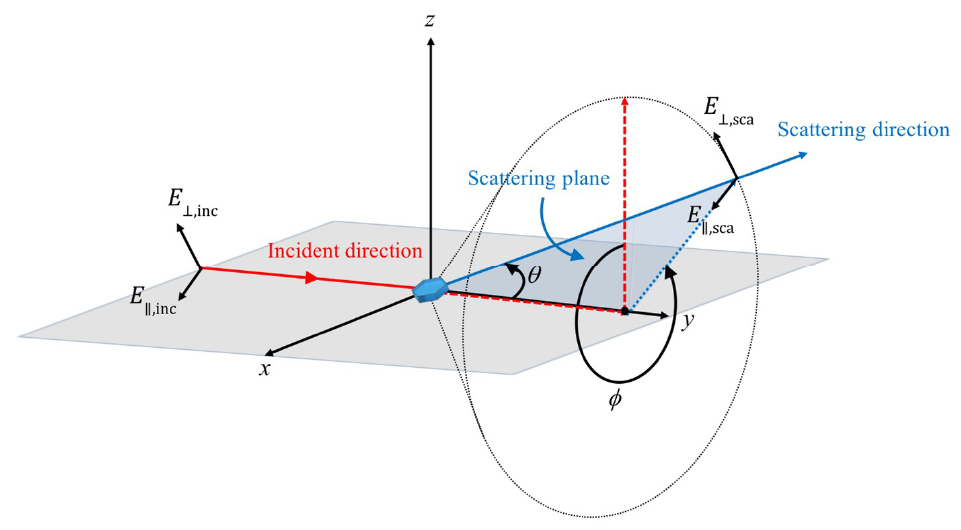
Figure 2. A schematic diagram illustrating the incident and scattering configuration for the scattering of light by a non-spherical particle.